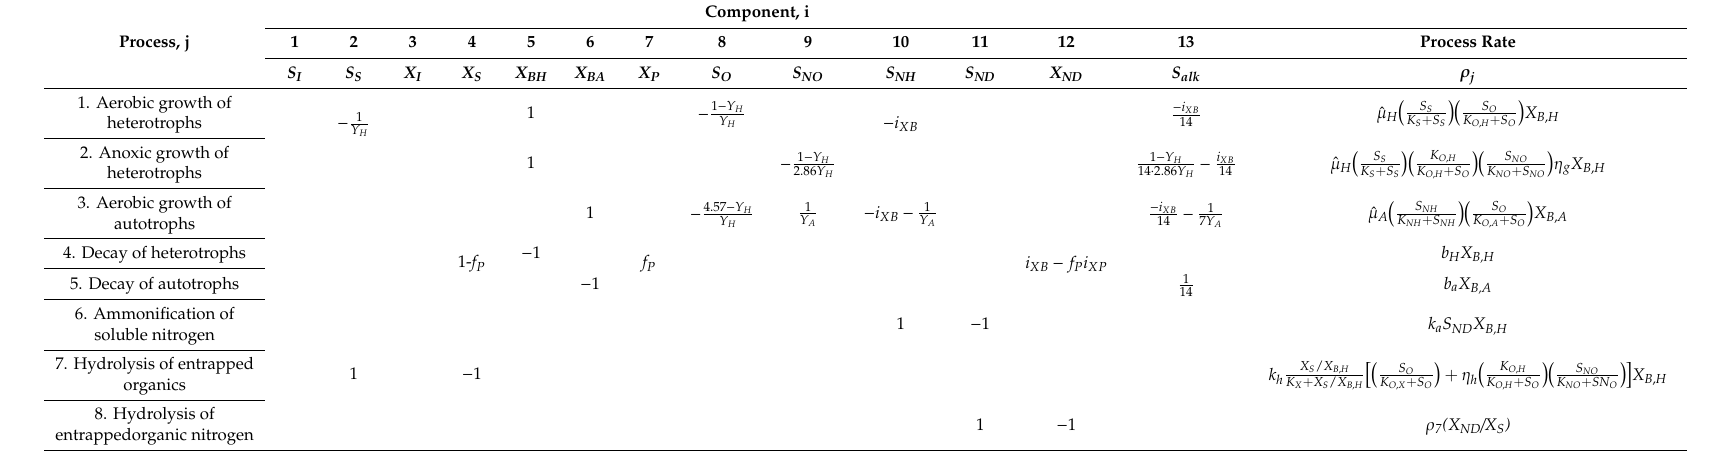
Table A2. Process kinetics and stoichiometry for carbon oxidation, nitrification and denitrification. Process,